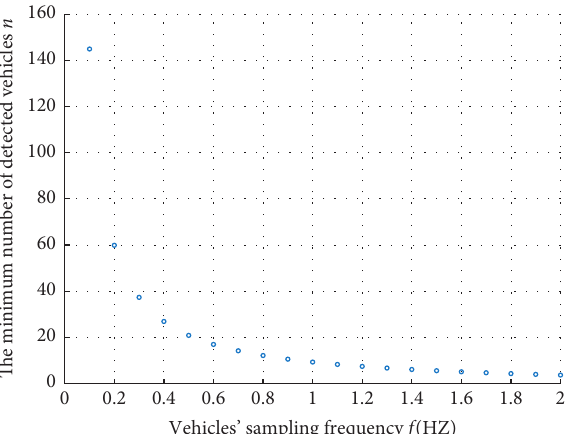
16: The relationship between sampling frequency and minimum number of vehicles at the detection speed of 50